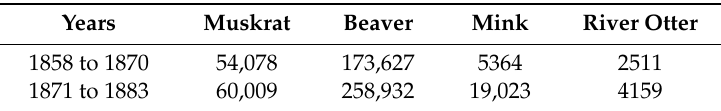
Table 1. Fur returns for muskrat, beaver, mink, and river otter in the Athabasca District, Canada from 1858 to 1883. Source: Hudson’s Bay